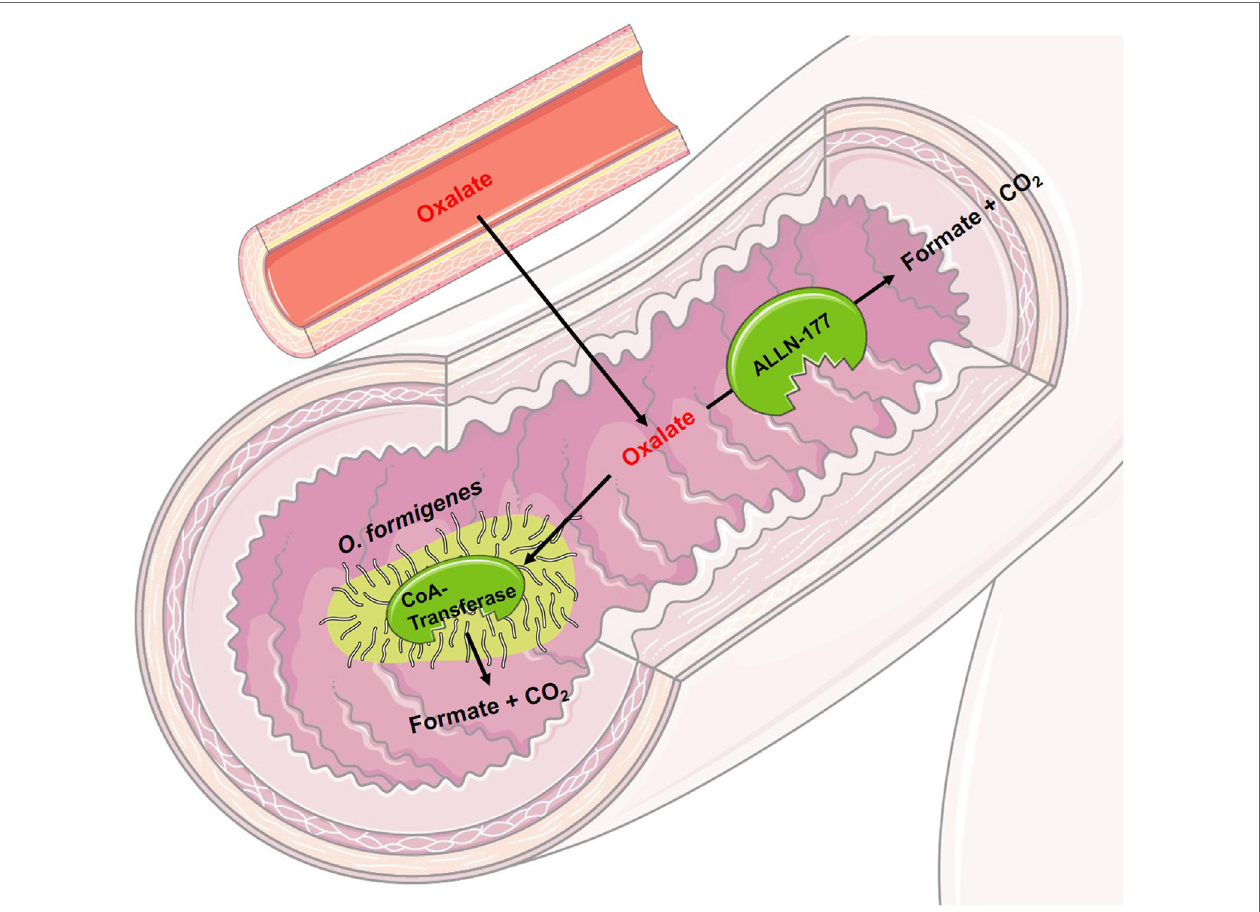
FiGURe 3 | Schematic figure of the mode of operation of experimental drugs for primary hyperoxaluria I. Oxalobacter formigenes uses oxalate as its sole carbon source. Orally administered, it degrades intraluminal oxalate in the intestine. By a concentration gradient and through activation of the intestinal oxalate transporter, oxalate is transported from the blood into the intestinal lumen. ALLN-177 is a recombined, microbial oxalate decarboxylase leading to the same intraluminal effect as O. Formigenes , however, maybe unable to increase the shift of blood oxalate into the intestinal lumen, as it cannot directly activate the intestinal oxalate